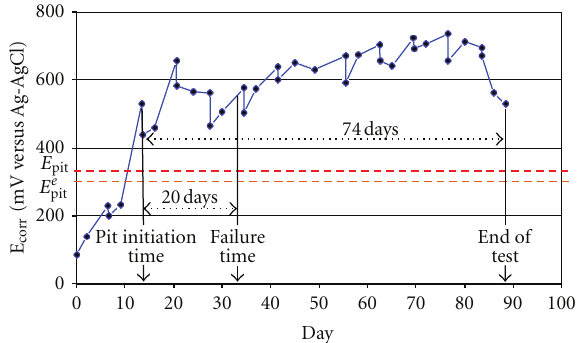
Figure 6: E corr versus time for small-scale test with free chlorine residual adjusted to 8 mg/L. Using E pit = 325 mV (versus Ag-AgCl), the pit initiation time (14 days) and the relative times available for maximum (20 days) and average (74 days) pit propagation were instead of E pit did not change estimated. In this test, using E e pit estimated initiation time and propagation rates since E corr rose above both values between the measurements on days 11 and